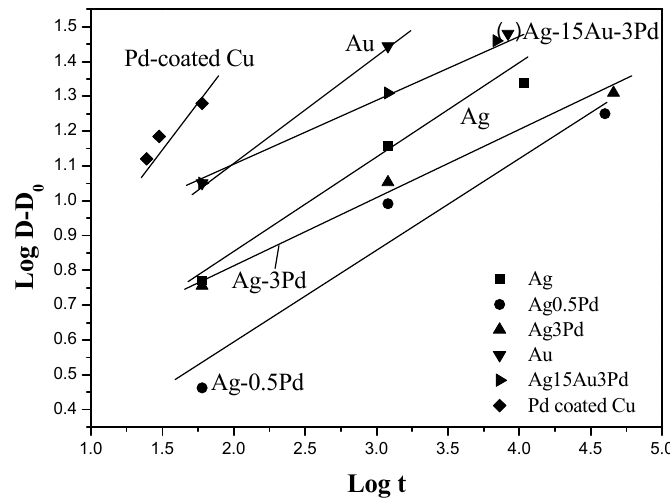
Figure 9. Log plots for the grain growth ( D t − D 0 ) of bonding wires after current stressing at 1.23 × 10 5 A/cm 2 for various times ( t ).